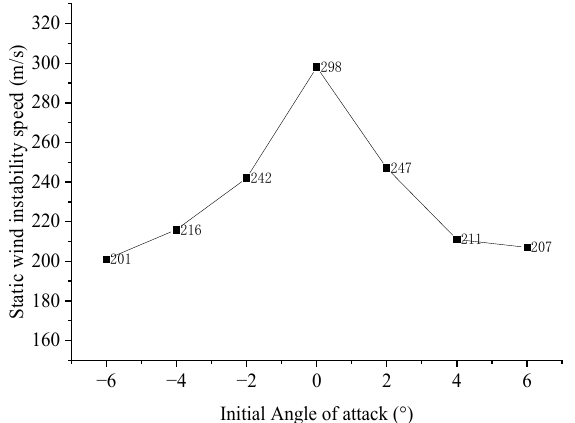
Figure 11. Variation curve of critical instability wind speed with the initial wind angle of attack.